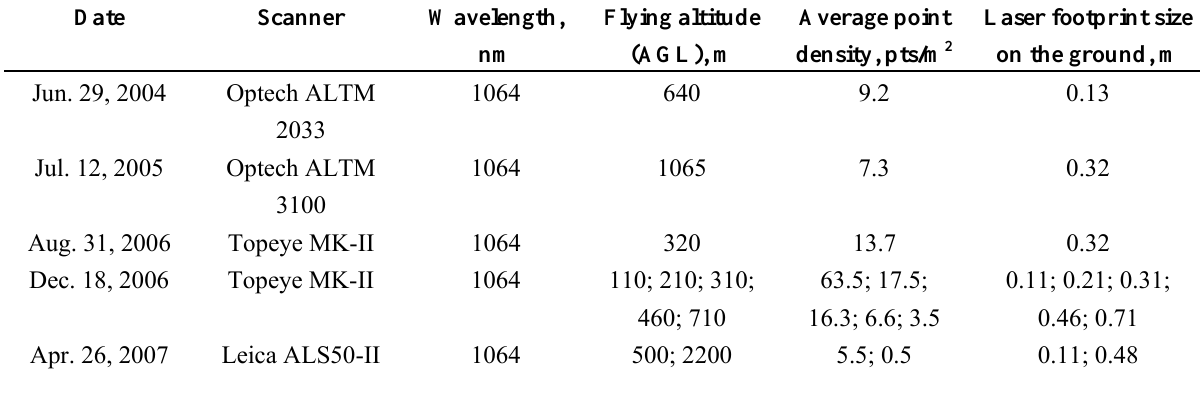
Table 1. Flight campaigns in Espoonlahti Harbor. Date when the campaign took place, scanner used, flying altitudes, average point density and laser footprint size on the